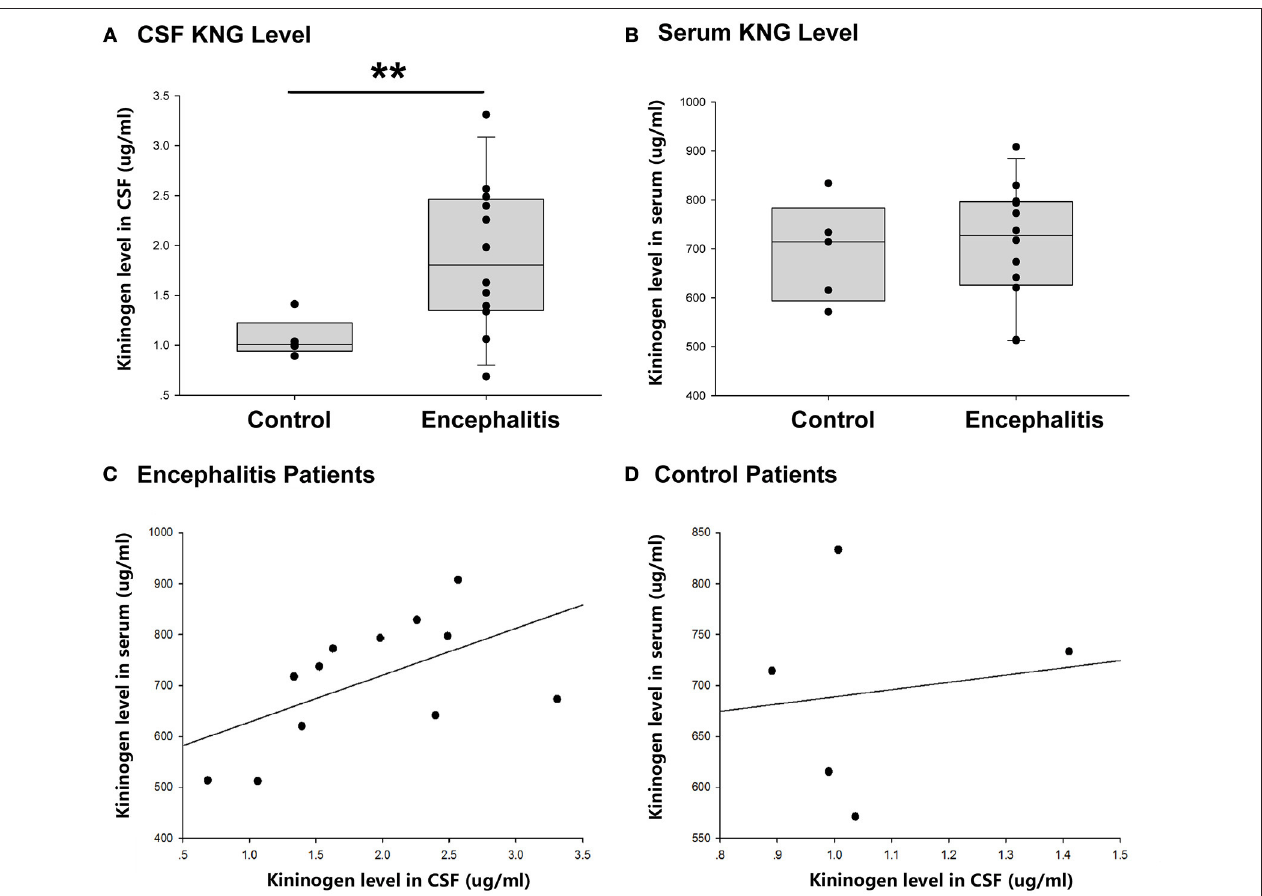
FIGURE 3 | CSF and serum KNG protein level of encephalitis patients and controls. (A) The level of KNG in CSF of encephalitis and control patients. (B) The level of KNG in serum of encephalitis and control patients. (C) The correlation of serum and CSF KNG levels in encephalitis patients. (D) The correlation of serum and CSF KNG levels in control patients. ** p < 0.01.